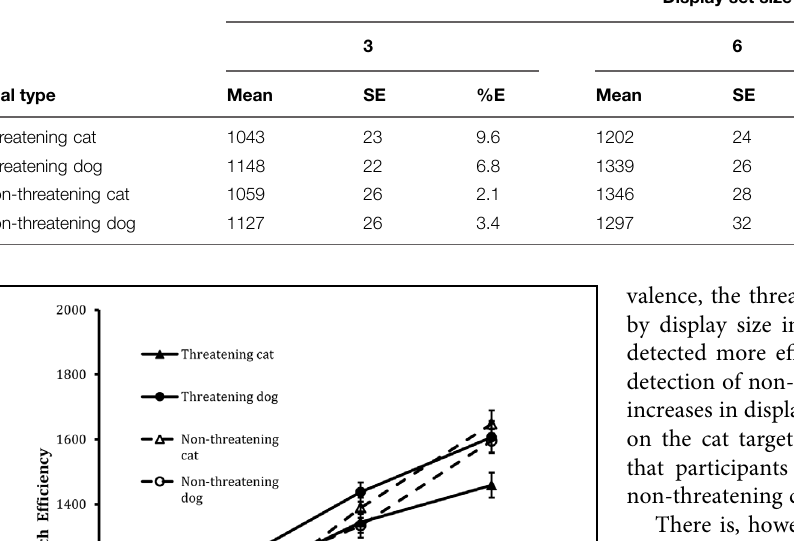
Display set size